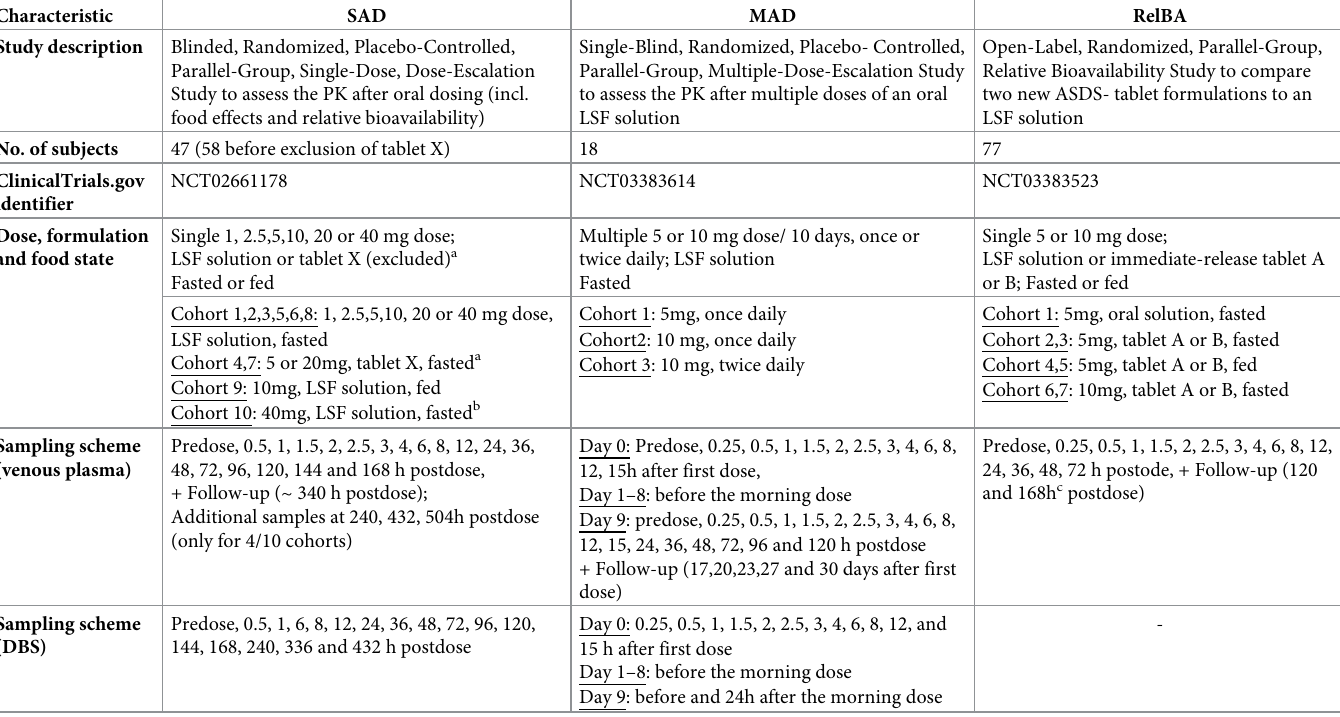
Table 1. Summary of clinical studies contributing to the pooled pharmacokinetic analysis. Characteristic SAD MAD RelBA Study description Blinded, Randomized, Placebo-Controlled, Single-Blind, Randomized, Placebo- Controlled, Open-Label, Randomized, Parallel-Group, Parallel-Group, Single-Dose, Dose-Escalation Parallel-Group, Multiple-Dose-Escalation Study Relative Bioavailability Study to compare Study to assess the PK after oral dosing (incl. to assess the PK after multiple doses of an oral two new ASDS- tablet formulations to an food effects and relative bioavailability) LSF solution LSF